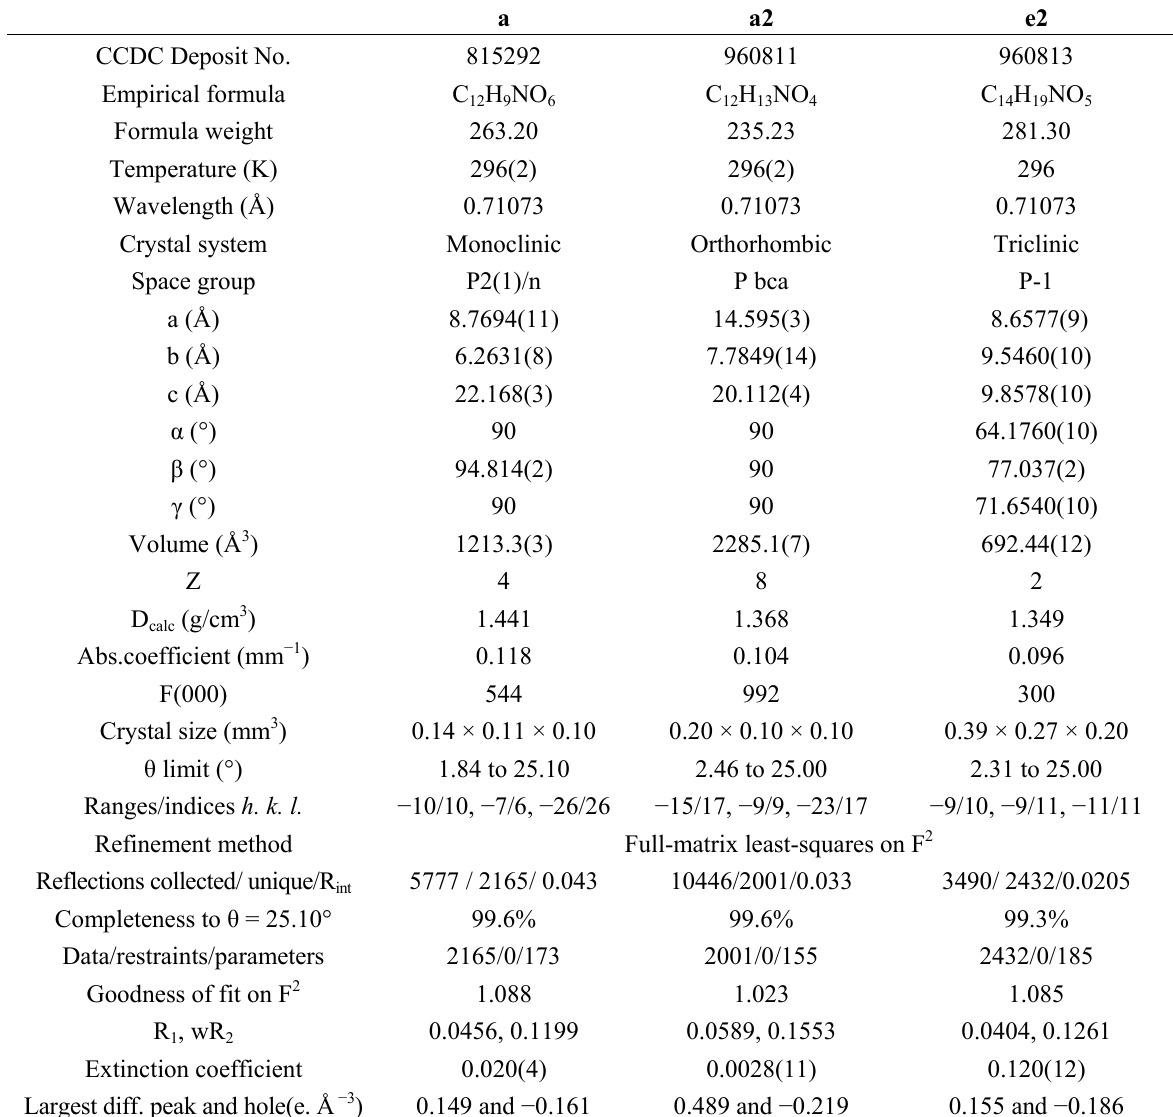
Table 1. Crystal data and structure refinement for a , a2 and e2